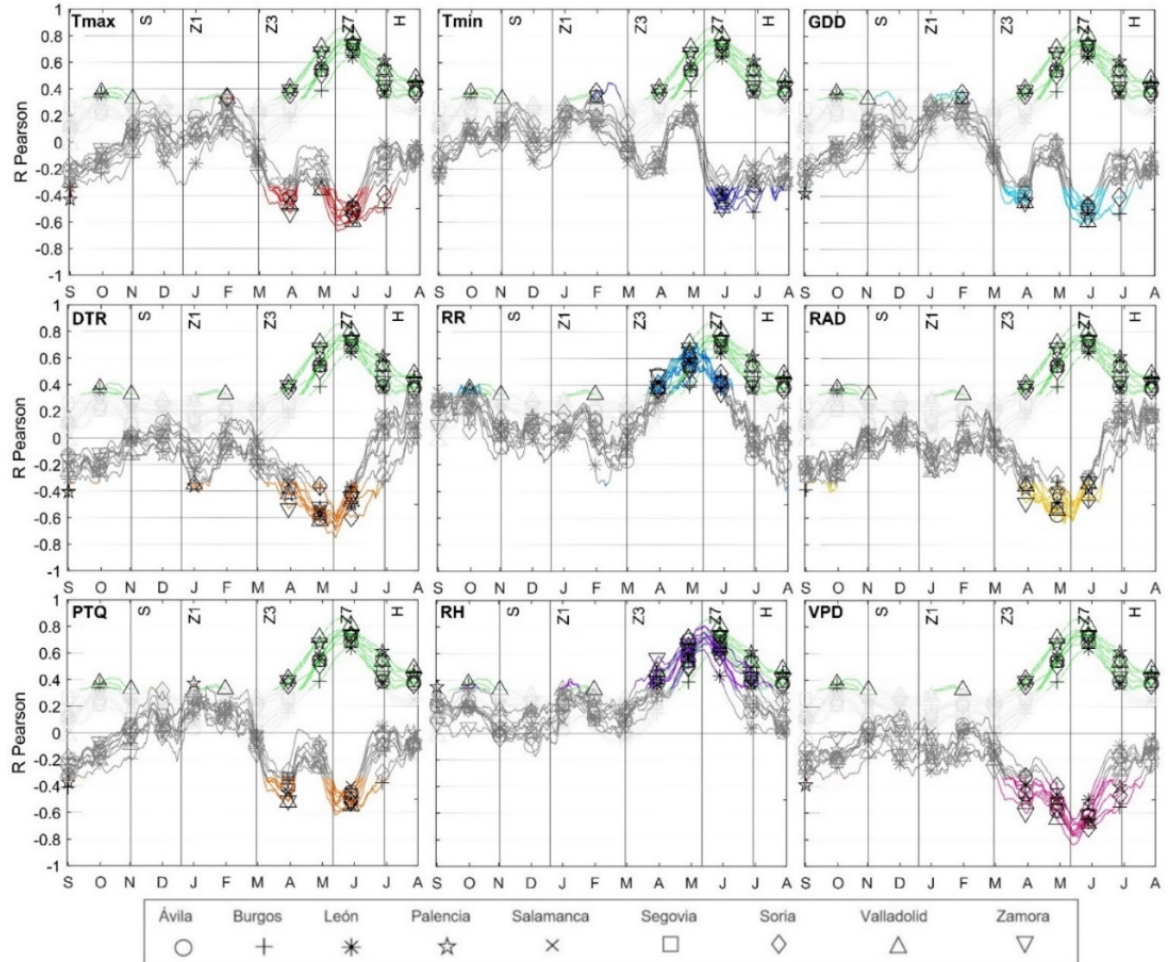
Figure 5. Daily correlations (line plots indicating the R coefficient values) and periods of significance (colored line segments) of the most relevant climatic variables with the annual yield of barley during the growing season in each province of CYL (see symbols). Vertical lines indicate phenological stages (Zi) of the Zadoks scale for barley in CYL. Periods of significant correlation of ERA5-Land soil moisture with annual barley yield (Figure 4(a1)) are shown in green and nonsignificant periods are in light gray for reference. Months are indicated on the primary x-axis and Zadok’s stages over the vertical lines from the secondary x-axis.